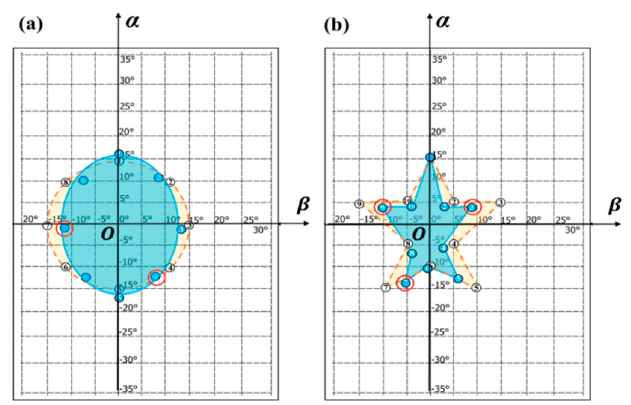
Figure 6. The extracted wrist ( a ) circular and ( b ) pentagonal motion trajectory patterns for the developed wearable sensor, where yellow dashed line and blue solid line represent the predetermined and recovered patterns, respectively.